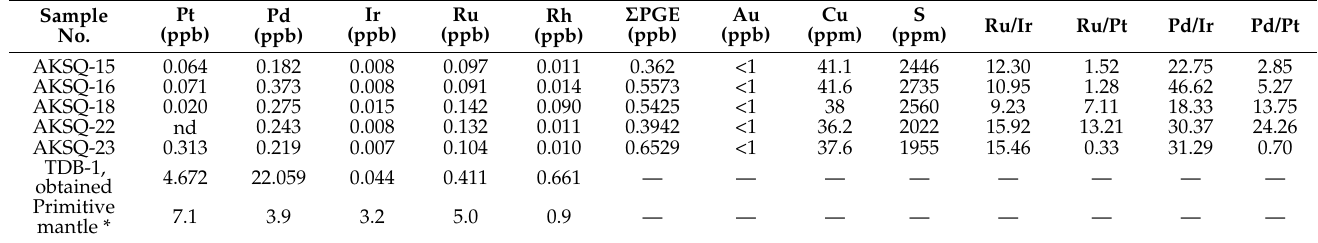
Table 2. PGE, Cu, Ni, and S concentrations in the Aksu diabase dykes, Chinese South Tianshan.